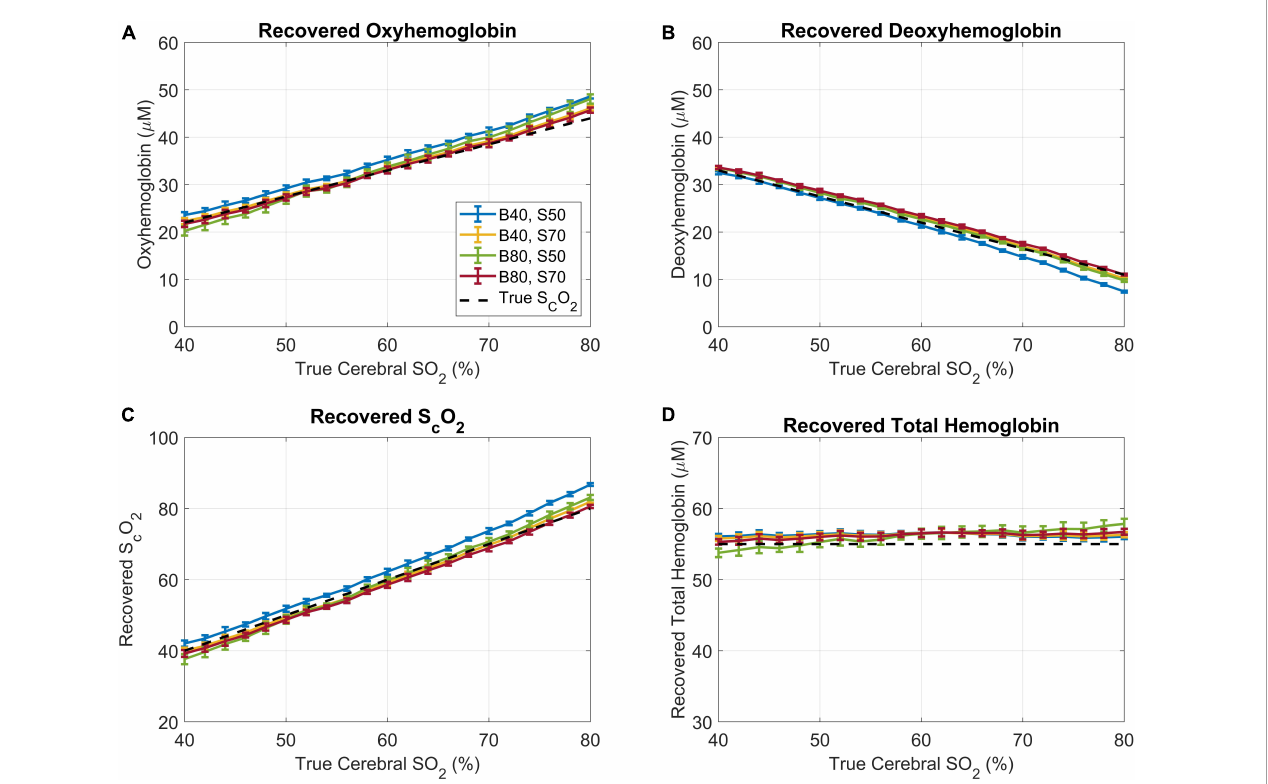
FIGURE8 Results of Phase 2 analysis when using a wide range of brain and scalp oxygen saturations as the baseline values for estimating f ECL . In the legend, (B) denotes the simulated cerebral oxygen saturation and S represents the simulated scalp oxygenation, both in percent. (A) The recovered oxyhemoglobin, (B) recovered deoxyhemoglobin, (C) recovered brain oxygen saturation, and (D) recovered total hemoglobin plotted versus the true cerebral oxygen saturation. The dotted black lines represent the “ground